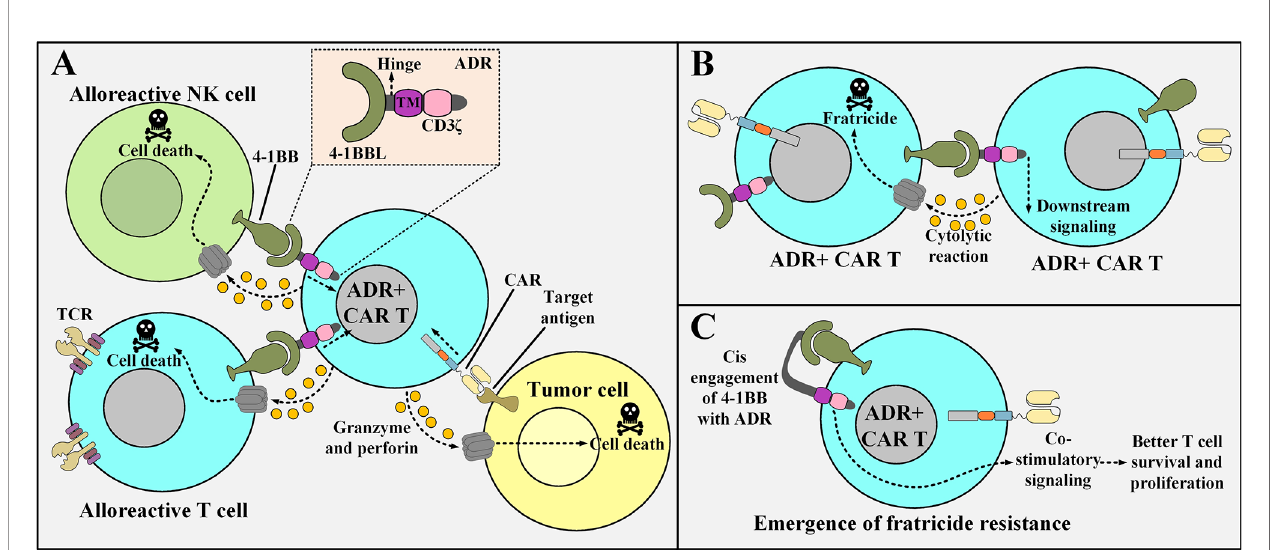
FIGURE 2 | The underlying of mechanism of action of ADR-expressing CAR T cells, the issue of their fratricide, and the possible mechanism of action for the emergence of fratricide-resistant ADR-positive CAR T cells. (A) ADR-expressing CAR T cells enforce cytolytic reactions only against alloreactive T cells and NK cells (that are activated with their 4-1BB upregulated) and manage to spare resting T cells and NK cell (that are non-alloreactive). On the other hand, they can also enforce tumoricidal responses against their target tumor cells. (B) Following their activation, ADR-positive CAR T cells upregulate 4-1BB. This makes them susceptible to fratricide (self-cytotoxicity). (C) A proposed underlying mechanism for the emergence of ADR-expressing CAR T cells that are resistant to fratricide. The surface expressed ADR reacts with the 4-1BB molecule that is upregulated after the activation of the ADR-positive CAR T cells. This phenomenon renders 4-1BB hidden from being recognized by other ADR-expressing CAR T cells (hence the ADR-expressing CAR T cell represented in the fi gure becomes fratricide-resistant). TM, transmembrane domain; 4-1BBL, a fragment derived from the 4-1BB ligand; ADR, alloimmune defense receptor; NK, natural killer; CAR, chimeric antigen receptor; TCR, T cell